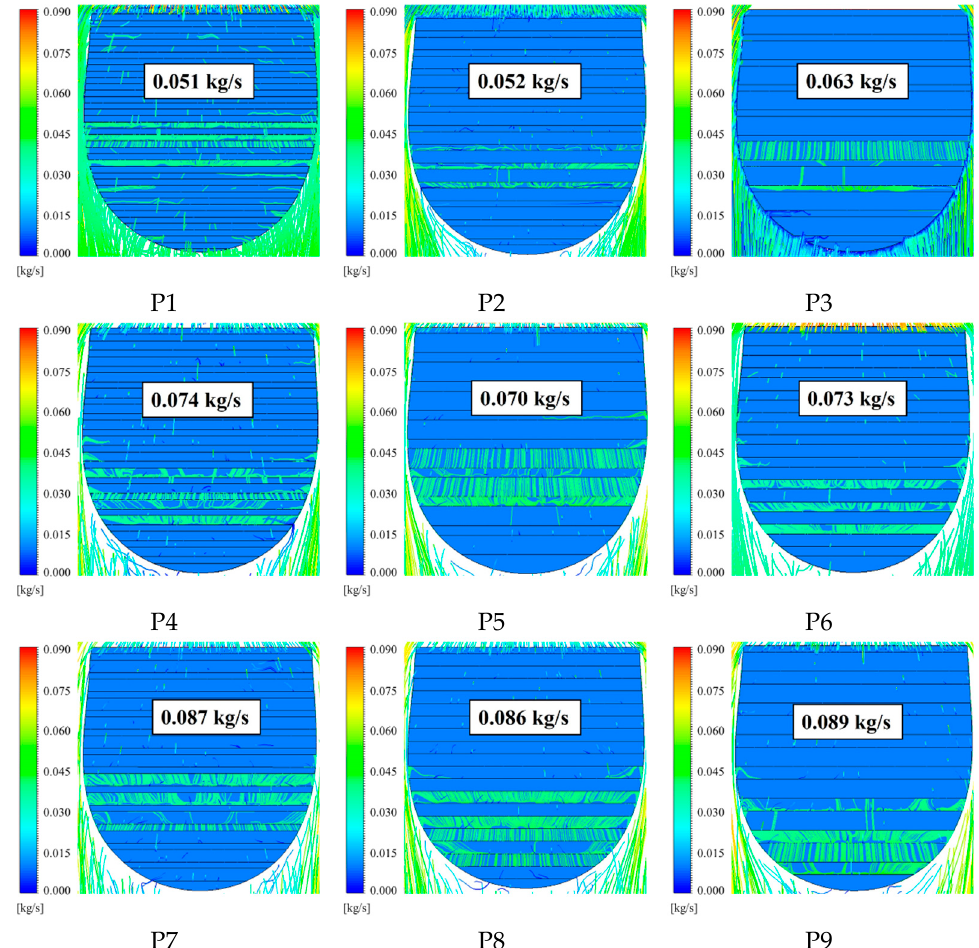
Figure 8. Mass flow rates through the outsole treads due to slipping simulations in the presence of water as a contaminant.